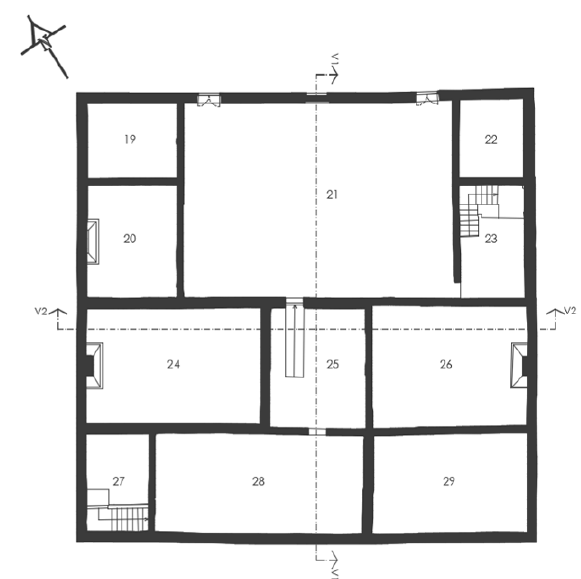
Figure 3: First floor plan H2 obtained from the points cloud (Municipality of